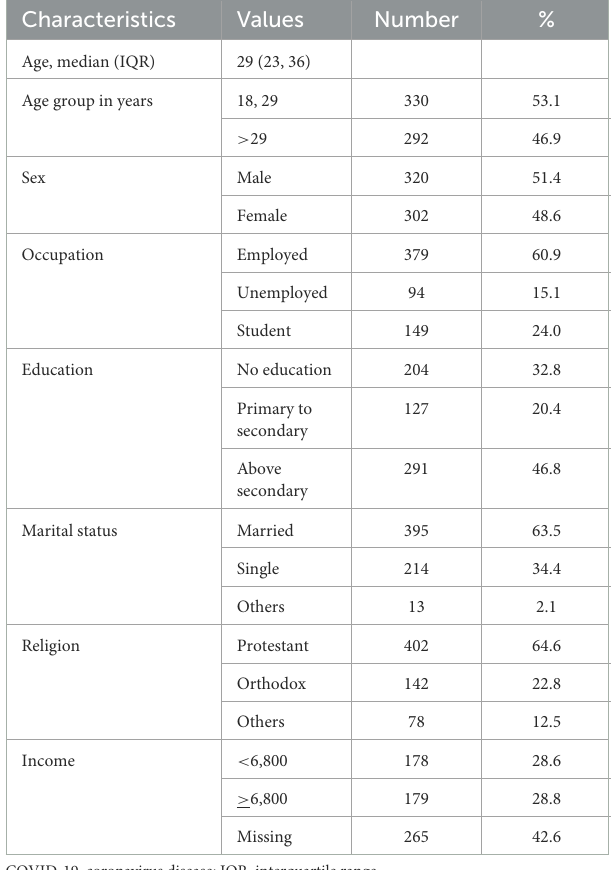
TABLE 1 Socio-demographic characteristics of the study participants.